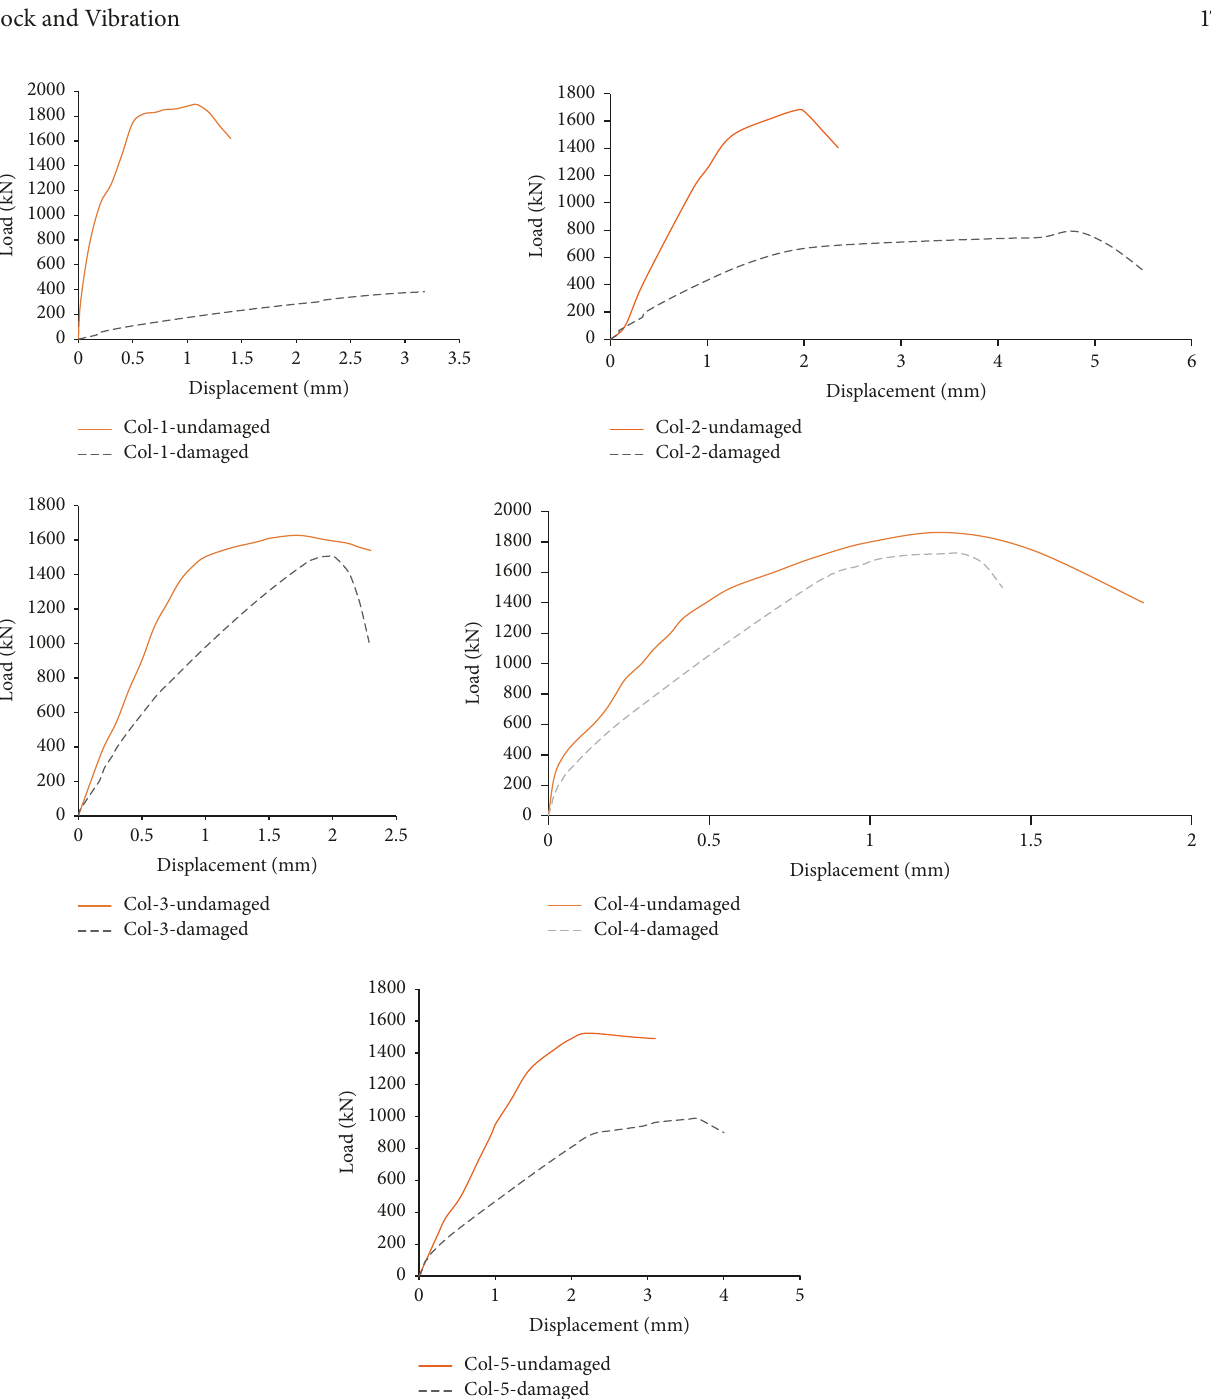
Figure 23: Axial load-displacement curves for the columns before and after blast